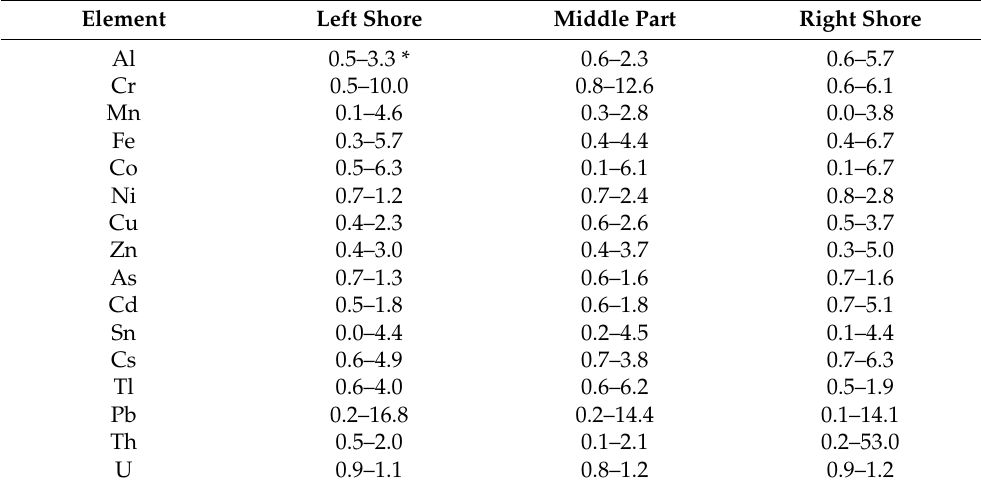
Table 2. Pollution indices CF in the water of Angara River source (March 2021–February 2022). Element Left Shore Middle Part Right